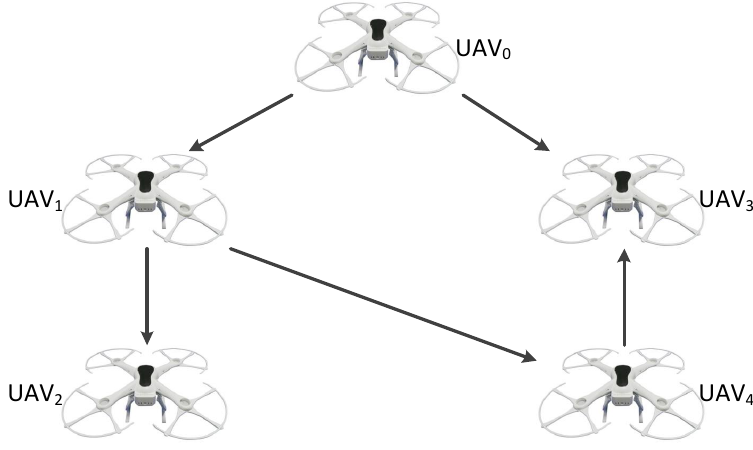
Figure 1. Topology graph for the UAV